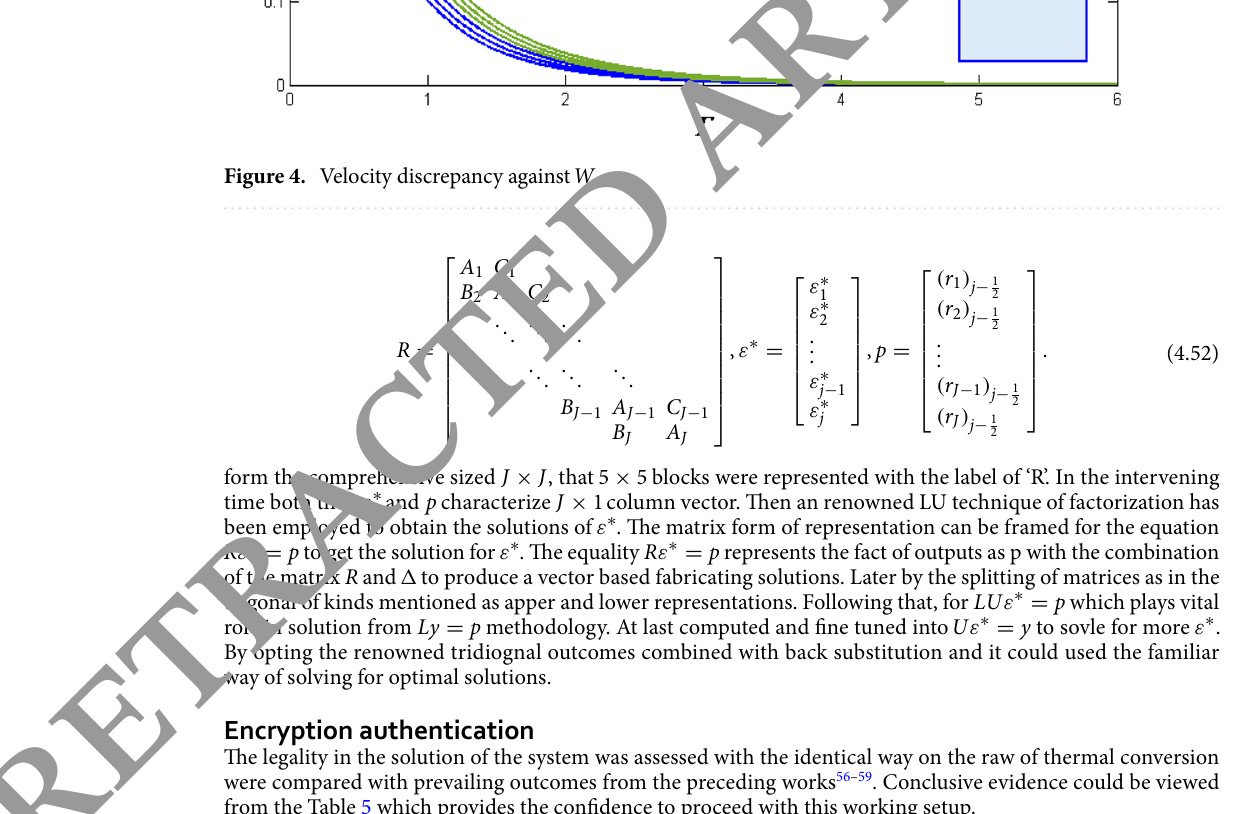
Figure 4. Velocity discrepancy against W e